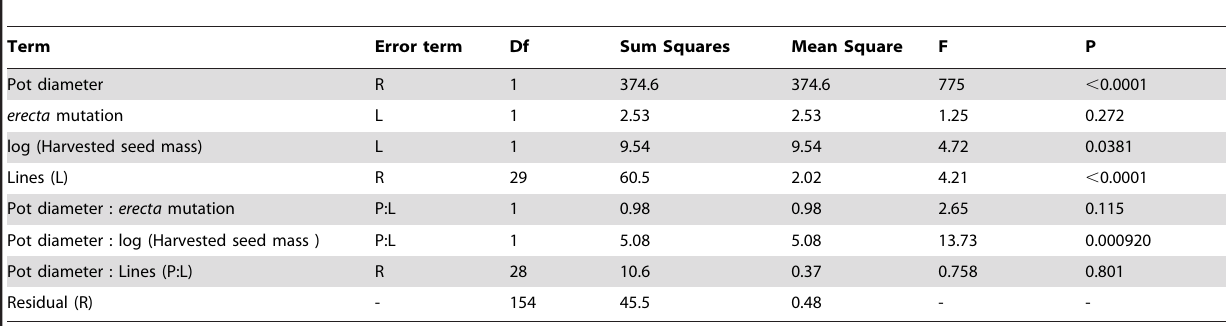
Table 7. ANOVA of harvested seed number with harvested seed mass fitted as the explanatory variable.